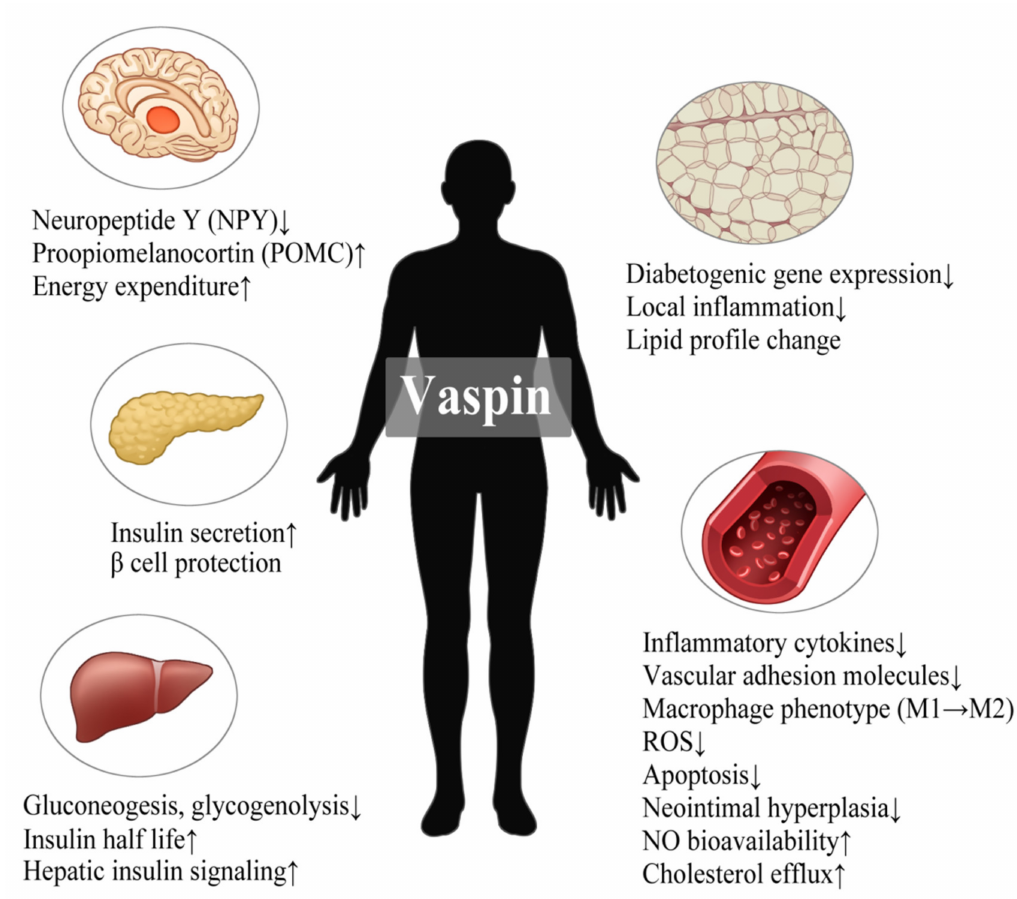
Figure 2. Beneficial effects of vaspin on metabolic health. Vaspin affects a broad range of organs simultaneously to enhance metabolic health. Aside from its anti-inflammatory function, vaspin intervenes in energy regulation, glycemic control, lipid profile, and vascular function. The up arrows denote the increase, while the down arrows denote the